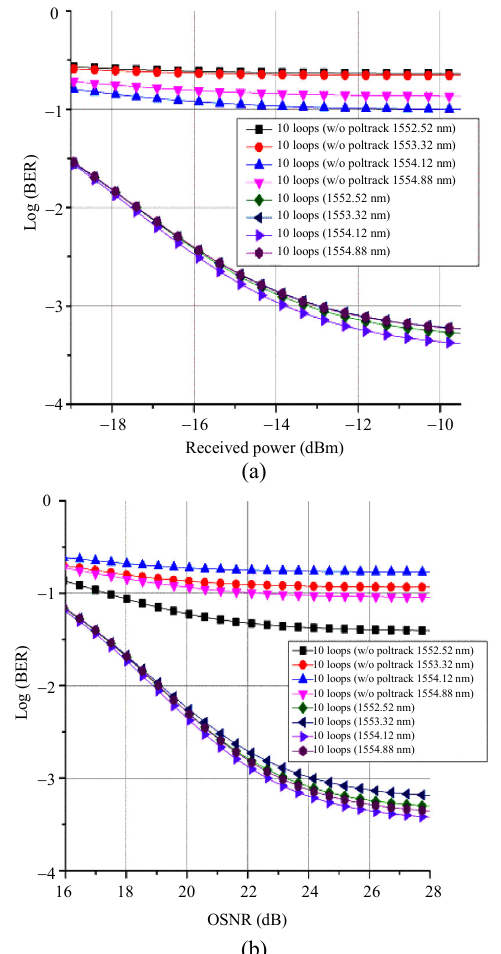
Fig. 9 Effects of polarization tracker and PMD using loops and FEC: (a) BER vs. ROP and (b) BER vs.